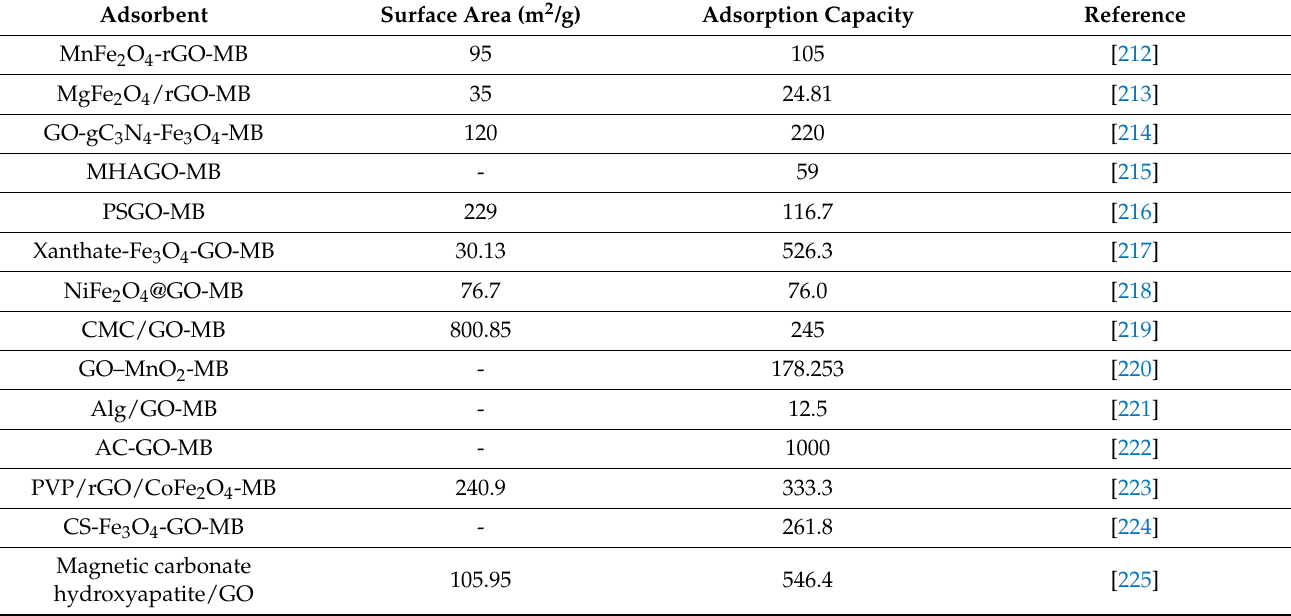
Table 7. Adsorption of Methylene Blue by Graphene Oxide–Metal